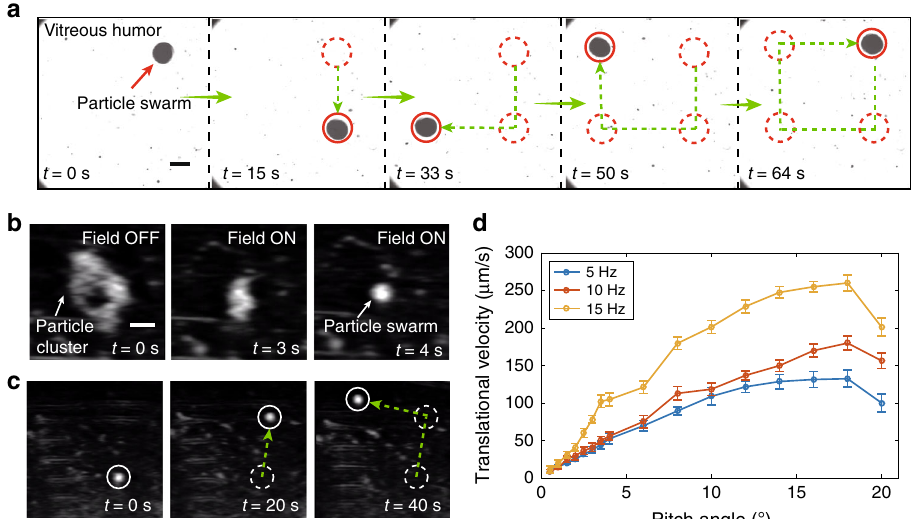
Fig. 7 Navigated locomotion of medium-induced swarms in bovine vitreous humour. a With optical imaging feedback, the medium-induced swarm is capable of following a rectangular trajectory. b The generation process of a medium-induced swarm in vitreous humour. c The navigated locomotion process in vitreous humour with ultrasound imaging feedback. The circles indicate the present location of the swarm, the dotted circles indicate the previous location of the swarm, and the green dotted arrows shows the moving trajectories of the swarm. d The translational velocity of the swarms formed by nanoparticles after hydrophobic surface treatment. The scale bars indicate 600 μ m. The error bars in d indicate standard deviations obtained from three